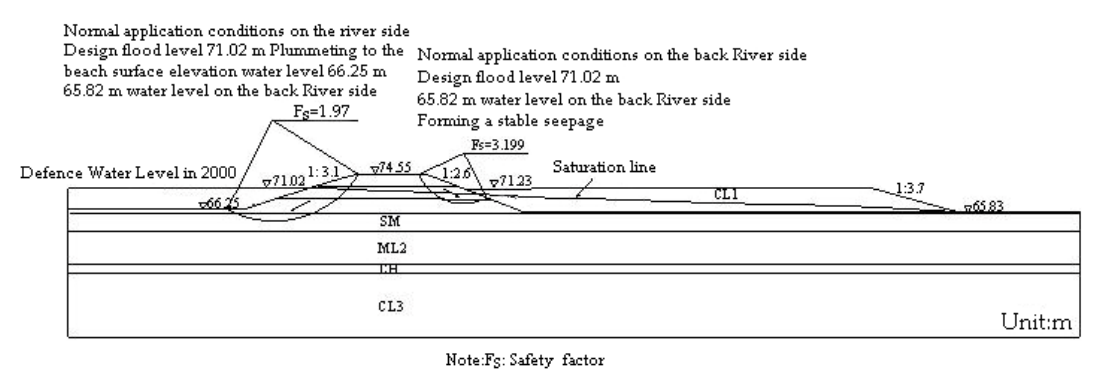
Figure 16. Calculation result of anti-sliding stability of typical dike section.